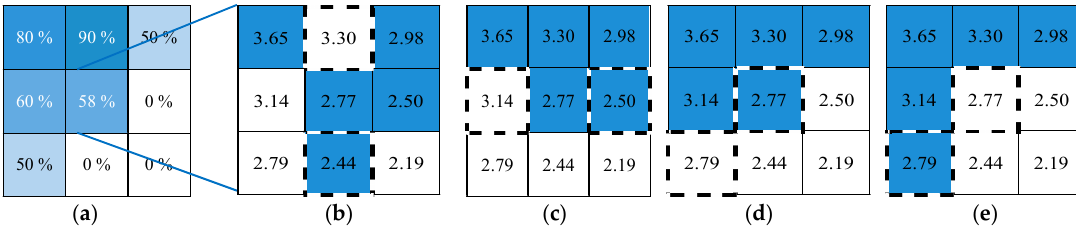
Figure 6. Water fractions and the pixel swapping (PS) process for spatial allocation of sub-pixels for a given pixel; ( a ) water fractions, ( b ) random allocation of sub-pixels, and ( c , d , e ) swaps (candidate sub-pixels for swapping are highlighted by dash-lines). Values of sub-pixels represent their attractiveness toward the water class.